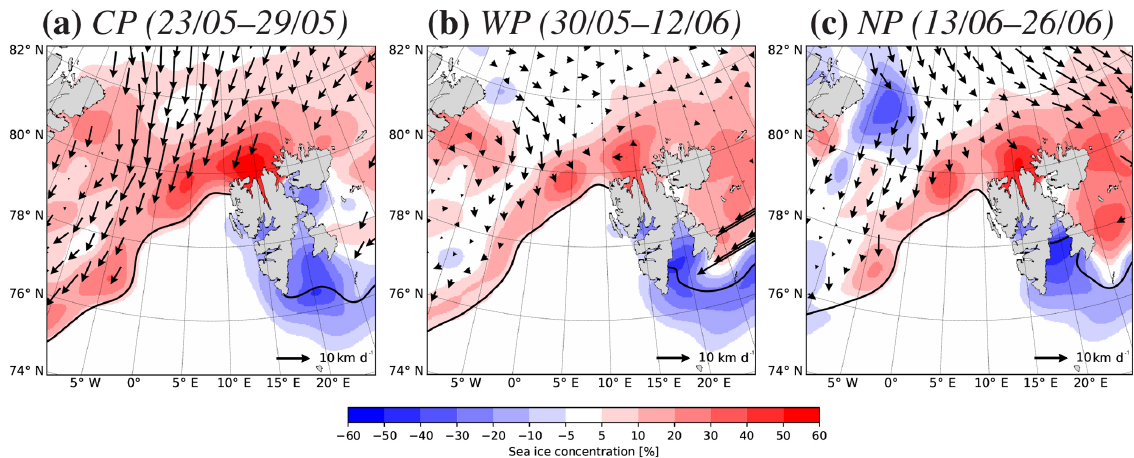
Figure 10. Anomalous sea ice concentration relative to climatologies (2017 minus 1979–2016; shading) and average sea ice drift (2017; vectors) for each ACLOUD/PASCAL key period from UB, NSIDC, and OSI SAF. The key periods are defined as (a) the cold period (CP), (b) the warm period (WP), and (c) the normal period (NP). White shading south of the 2017 sea ice edge (line) indicates open